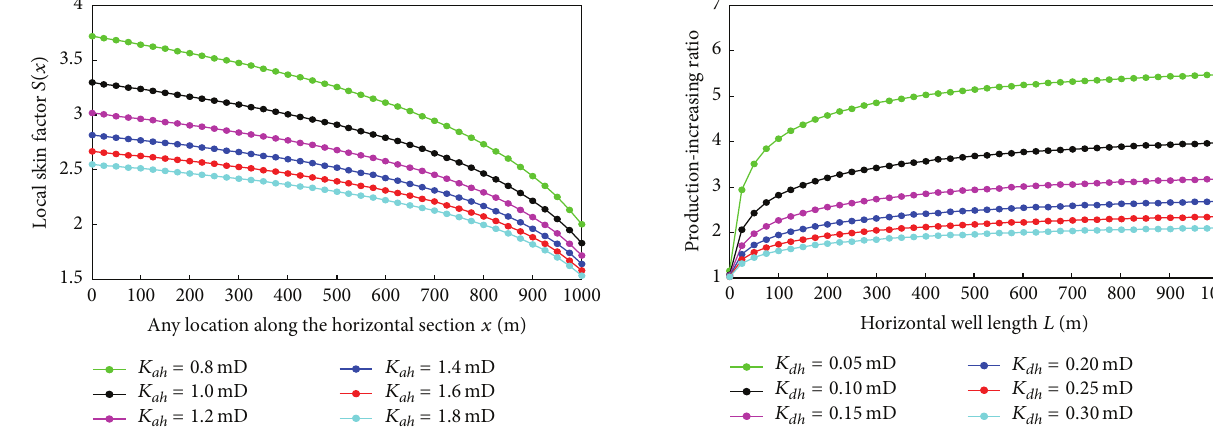
= 20 MPa, 𝑤𝑓 = 1.2 mD, 𝑑 = 1.6 m, 𝑎ℎ V . max = 0.15 V . min